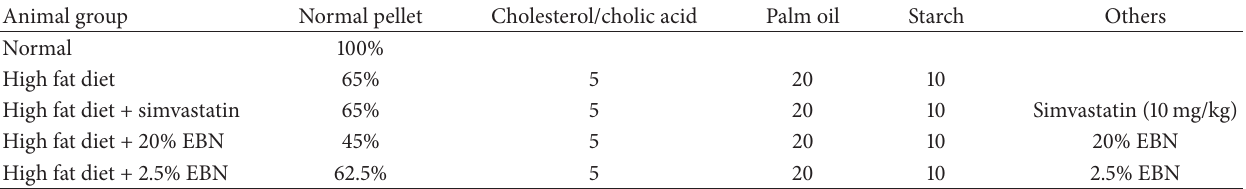
Table 1: Food composition and animal